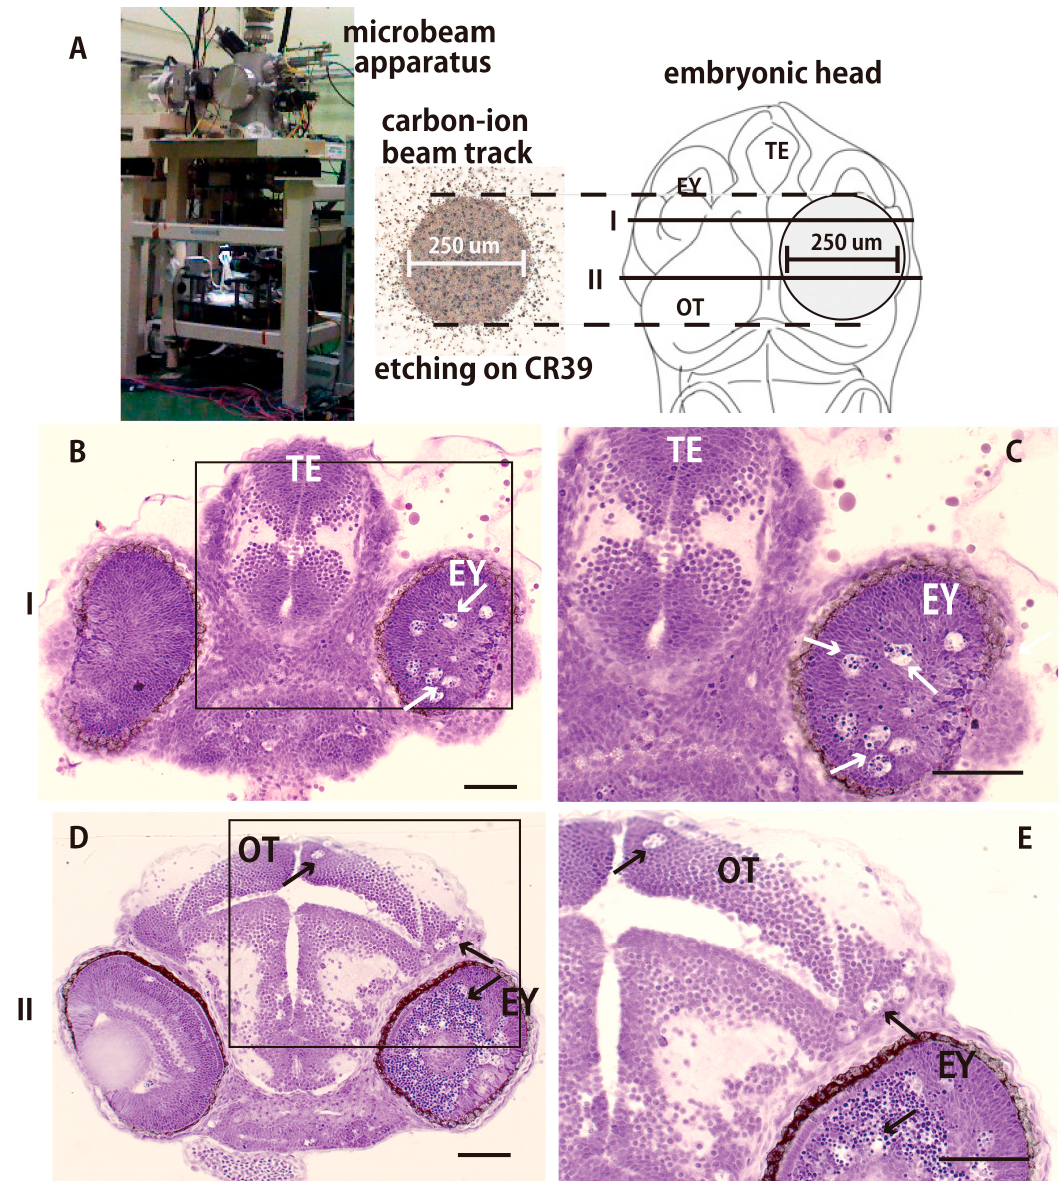
Figure 2. Apoptotic neuronal deaths were induced only in the targeted irradiated area 24 h after irradiation. ( A ) A collimated carbon ion microbeam (250 μ m diameter) characterized by etching on CR39, was used to locally irradiate the right hemisphere of optic tectum (OT). Nissl-stained frontal sections of the locally irradiated brain were prepared at the solid lines (I and II in A ) and shown in B – E , respectively. Many pyknotic cells were induced only in the right retina (arrows in B – E ) and the right hemisphere of the OT (arrows in D , E ). ( B , C ) show the frontal sections prepared at the solid line labeled I in A , and ( D , E ) show the frontal sections prepared at the solid line labeled II in A . OT, optic tectum; TE, telencephalon; EY, eye. Scale bars = 50 μ m.